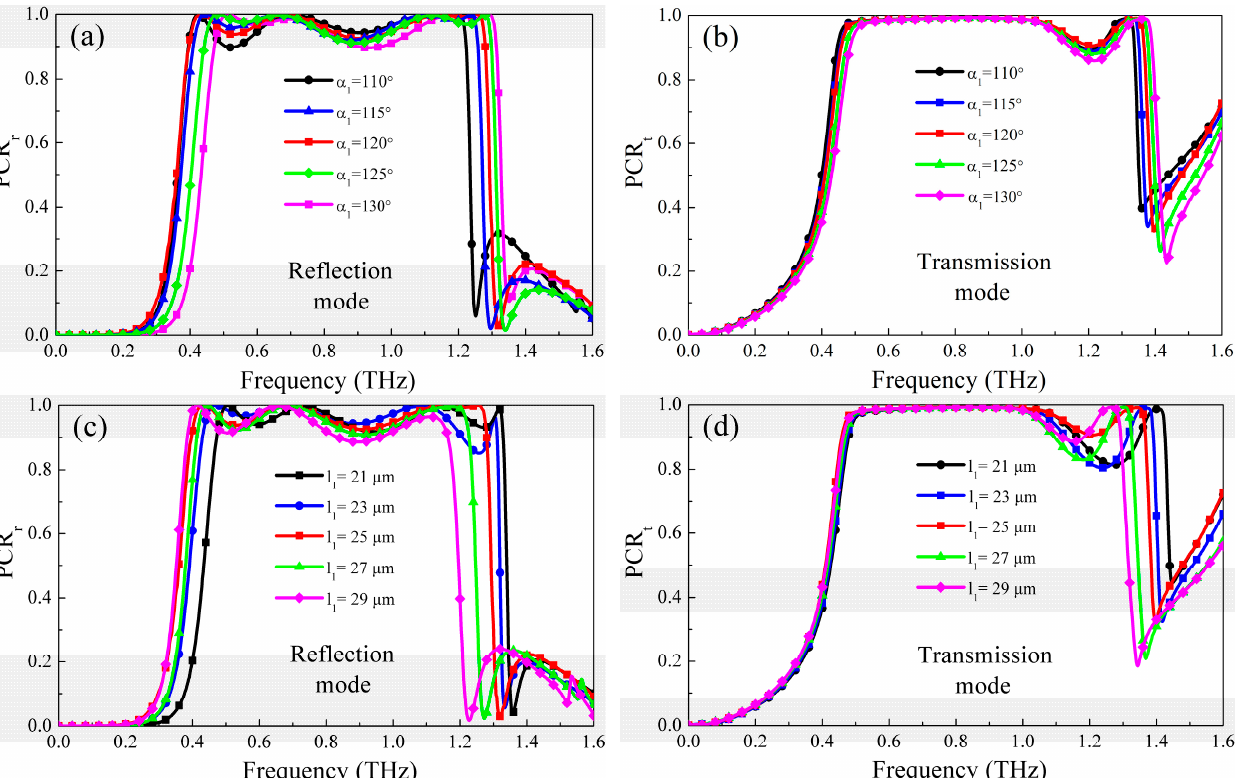
Figure 9. The PCR under different structure parameters ( a , b ) different α 1 ; ( c , d ) l 1 .